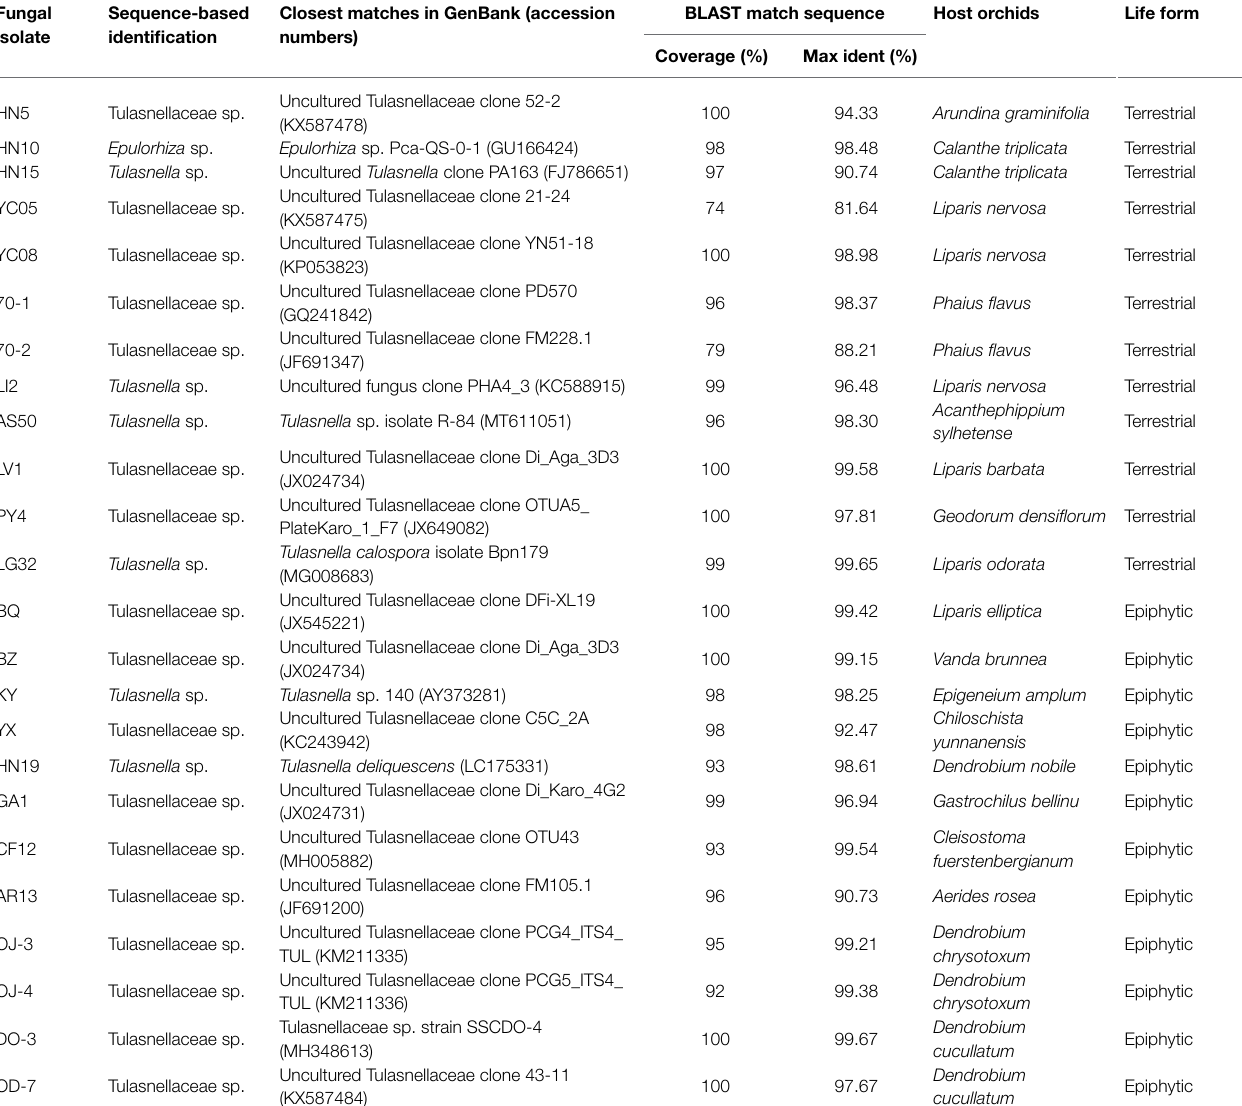
TABLE 1 | Tulasnellaceae spp. isolated from orchids with different life forms. Fungal Sequence-based isolate